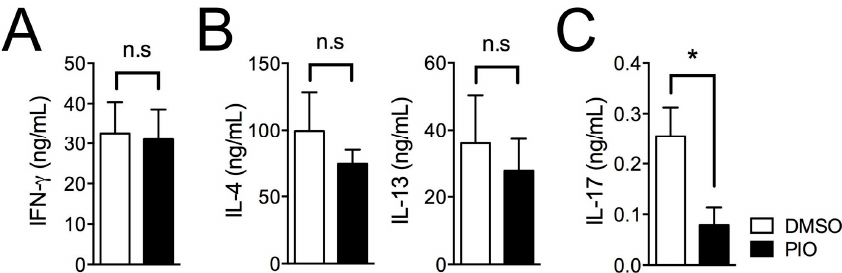
Figure 4. Selective inhibition of IL-17 production in Th17 cells from male mouse T cells by pioglitazone treatment. Accumulated cytokine expression of IFN- γ in Th1 cells ( A ); IL-4 and IL-13 in Th2 cells ( B ); and IL-17A in Th17 cells ( C ) in cultured supernatants from male T cells treated with DMSO or pioglitazone (20 μ M) was measured by ELISA. Values represent mean ± SEM ( n = 4~5). * p < 0.05; n.s: